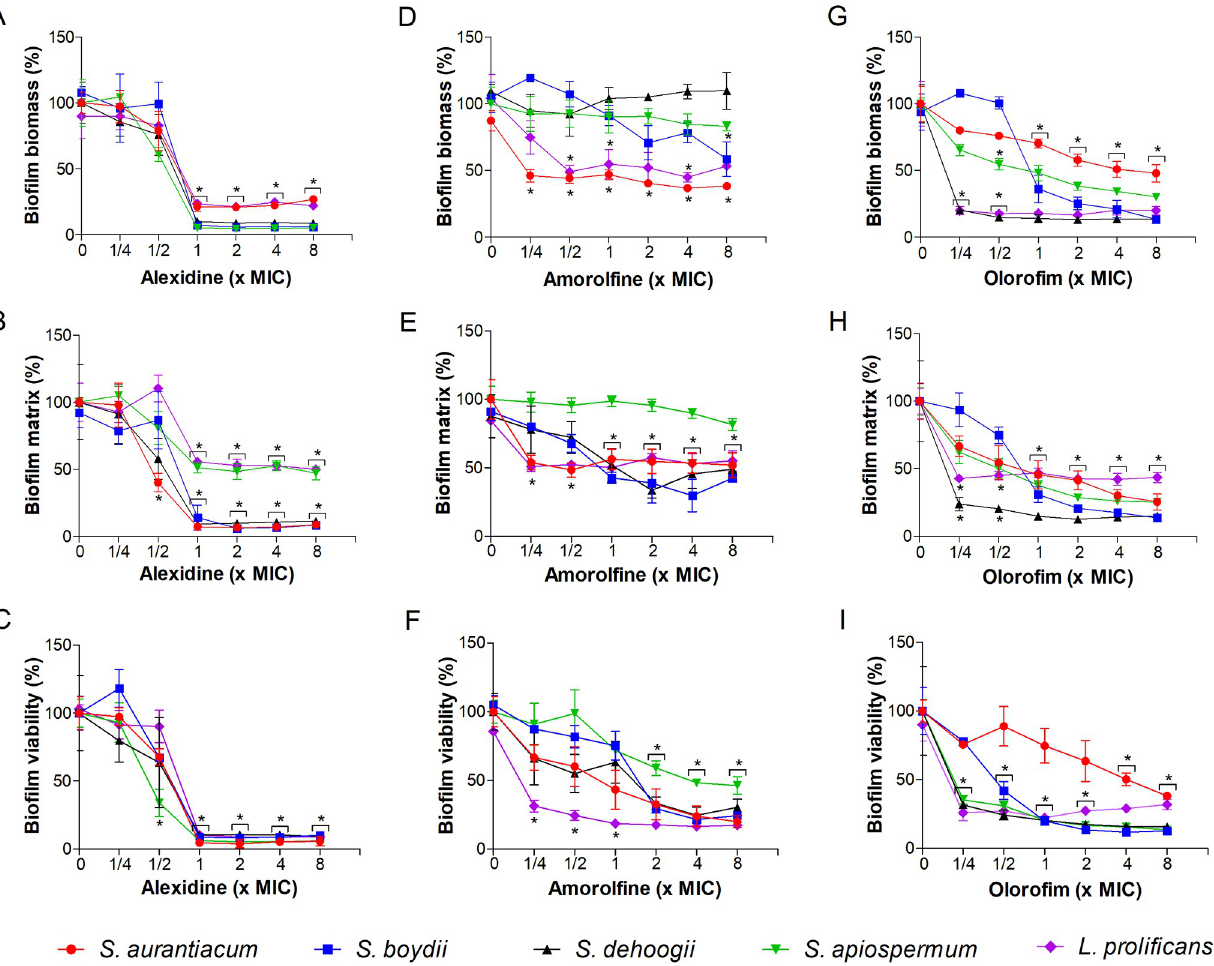
Fig 3. Effect of alexidine, amorolfine and olorofim on biofilm formation of Scedosporium and Lomentospora species. Fungal cells were adhered on the polystyrene surface for 1.5 h and then different concentrations of alexidine, amorolfine or olorofim were added. Fungal biomass (A, D and G), extracellular matrix (B, E and H) and viability (C, F and I) were measured using crystal violet, safranin and XTT-reduction assay, respectively. � p < 0.01, compared to zero (absence of drug) for each species. Experiments were performed in quadruplicate, in three independent experimental